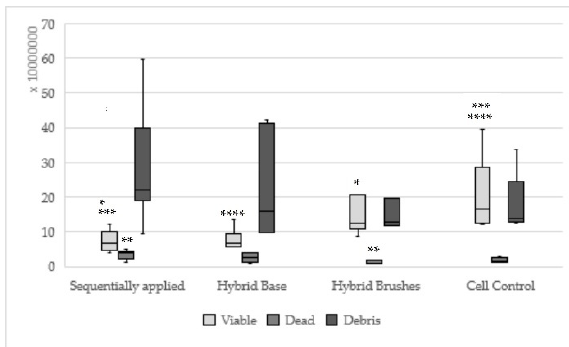
Figure 2. Results of hybrid bond sequentially applied, single applied (Hybrid base, hybrid brushes) and cell control; (sequentially applied vs. hybrid brushes * viable: p = 0.008 ** dead: p = 0.003; same asterisks show significant differences in the corresponding groups).